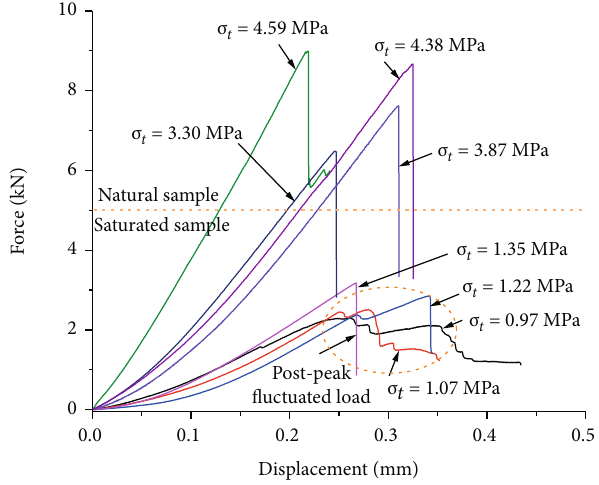
Figure 5: Force-displacement curves of the Brazilian test for natural and fully saturated rock samples.